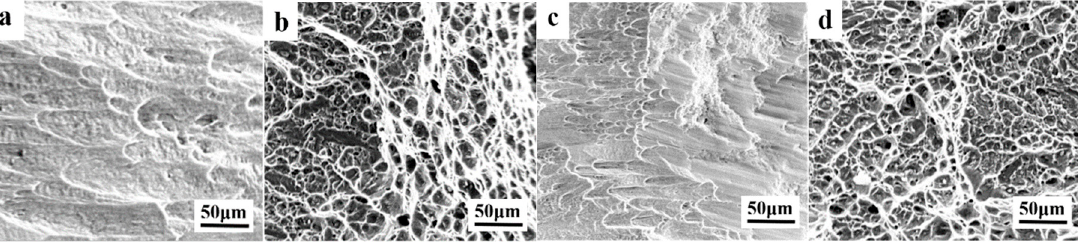
Figure 7. SEM images of the compressive fractured surface of the ( a ) edge and ( b ) center of the Ti 40 Ni 40 Cu 20 alloy, and the ( c ) surface and ( d ) center of the Ti 39 CeNi 40 Cu 20 alloy.